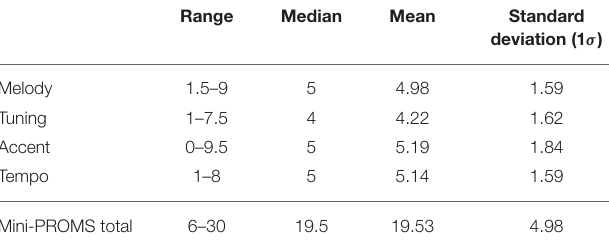
TABLE 4 | Mini-PROMS range, median, mean, and standard TABLE 3 | Intercorrelations (Pearson’s R) of subscales of GMSI scores. Active Perceptual Musical Emotions Singing engagement abilities training abilities